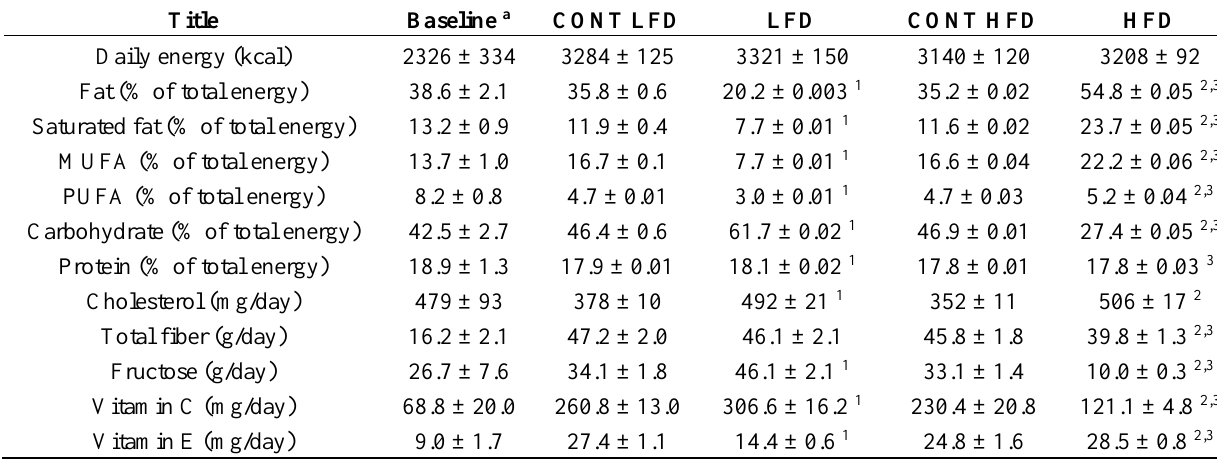
Table 1. Diet composition: baseline diet as estimated by 3-day food record and study diets